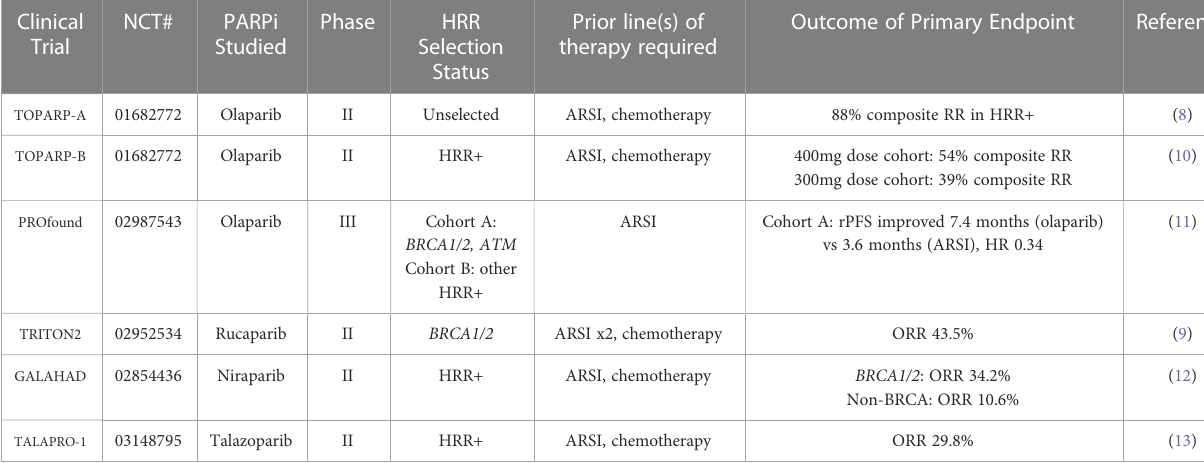
NCT(clinicaltrials.govregistration),Androgenreceptorsignalinginhibitor(ARSI),homologousrecombinationrepair(HRR),homologousrecombinationrepairde fi cient(HRR+),responserate (RR), overall response rate (ORR), radiographic progression free survival (rPFS), hazard ratio (HR).